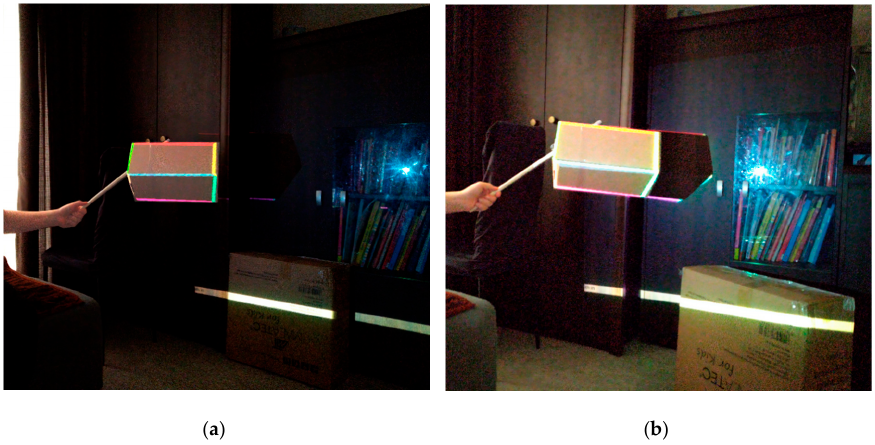
Figure 10. “Painting” edges of box made in the scene with other items similar to the mapped one: ( a ) the similar box set in the first position, ( b ) the similar box set in the second position.